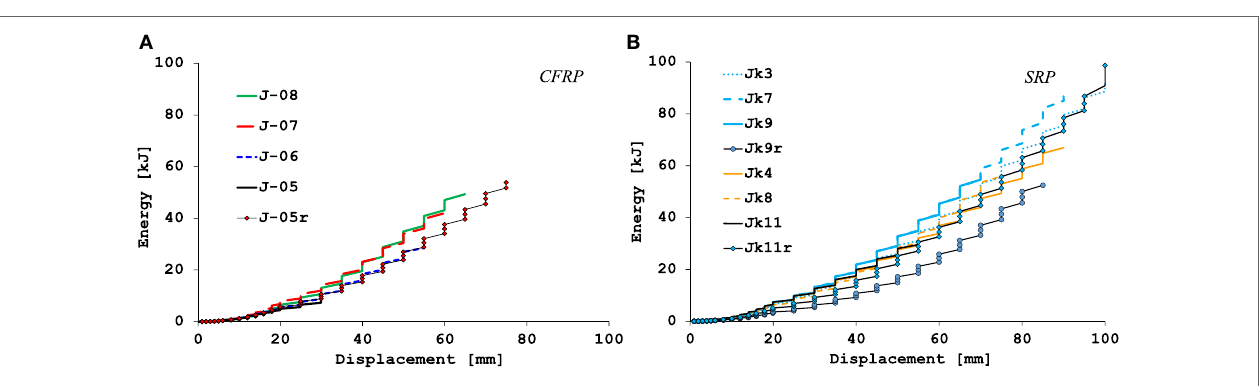
FIGURE 13 | Energy dissipation: CFRP strengthened specimens (A) ; SRP strengthened specimens (B) .